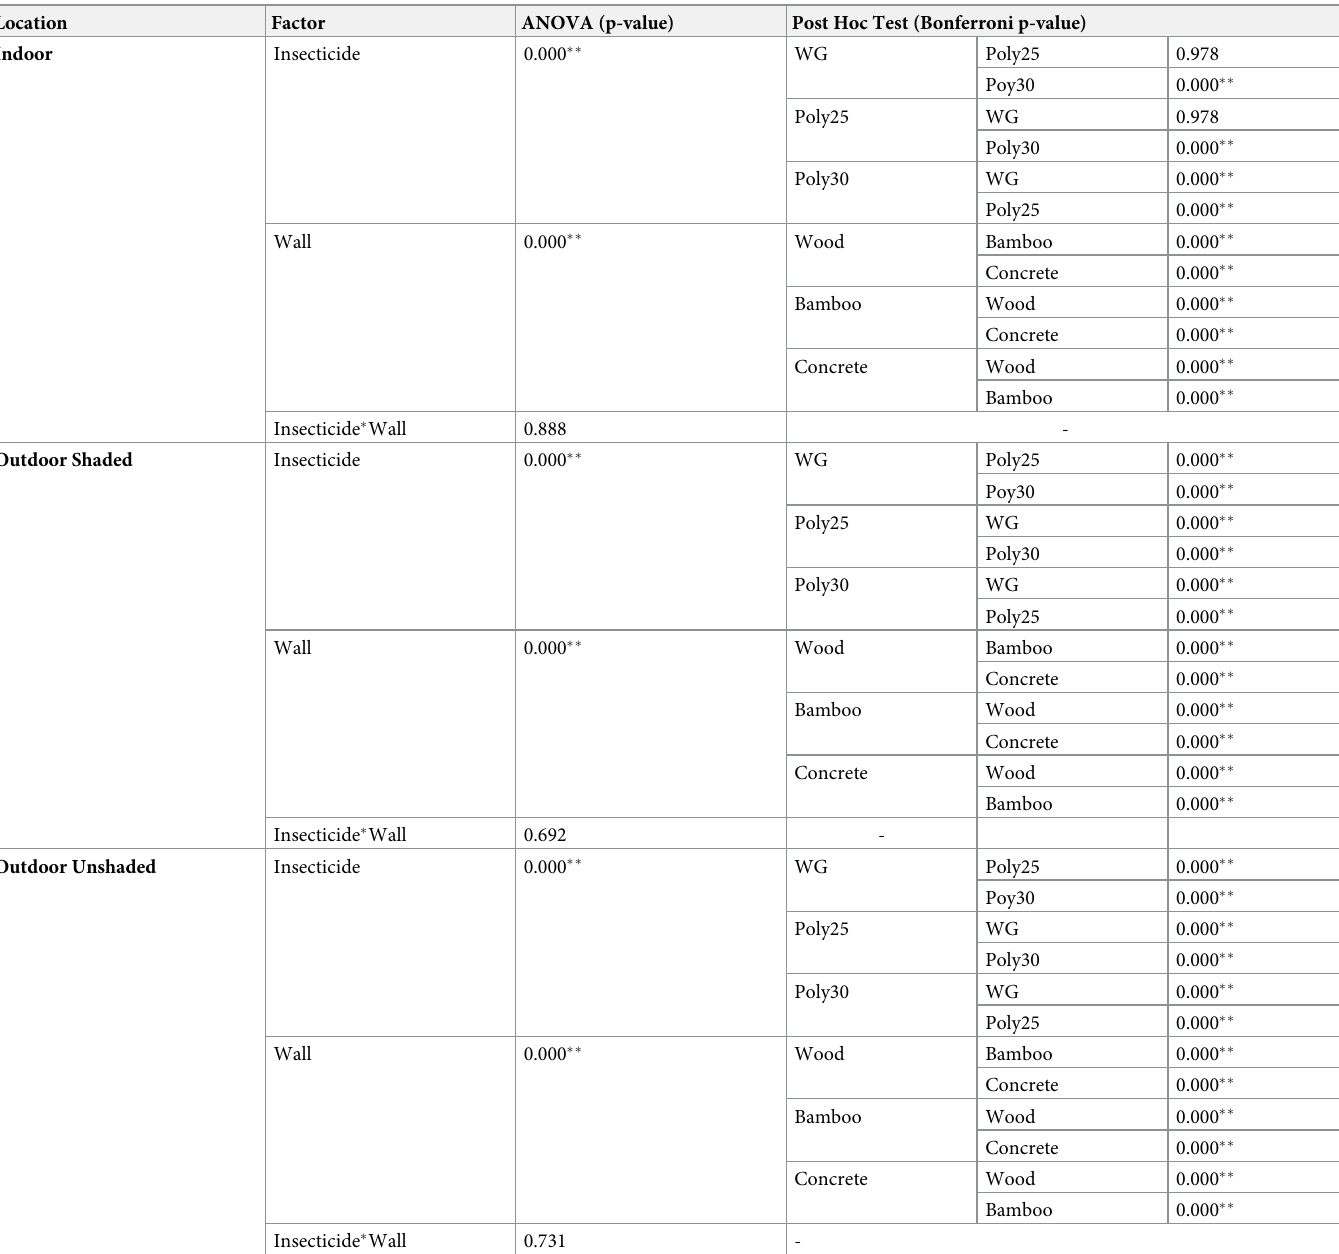
Table 2. Summary of ANOVA (p-values) for overall mortality rate according to each location. Location